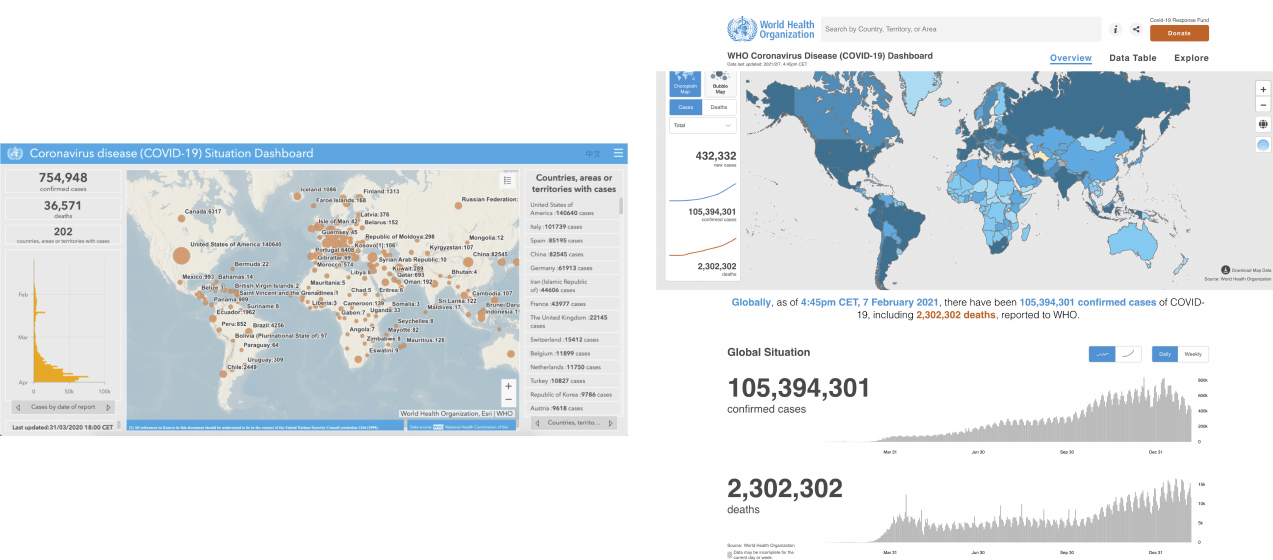
Figure 1. Different representations of the geo-dashboard showed on the online endpoint owned by the World Health Organization to inform visitors on the COVID-19 pandemic spread. Left: first version; previously available online at https://experience.arcgis.com/experience/685d0ace521648f8a5beeeee1b9125cd from January to April 2020; screenshot date: 31 March 2020. Right: second version; available online at https://covid19.who.int/ after April 2020 onward; screenshot date: 8 February